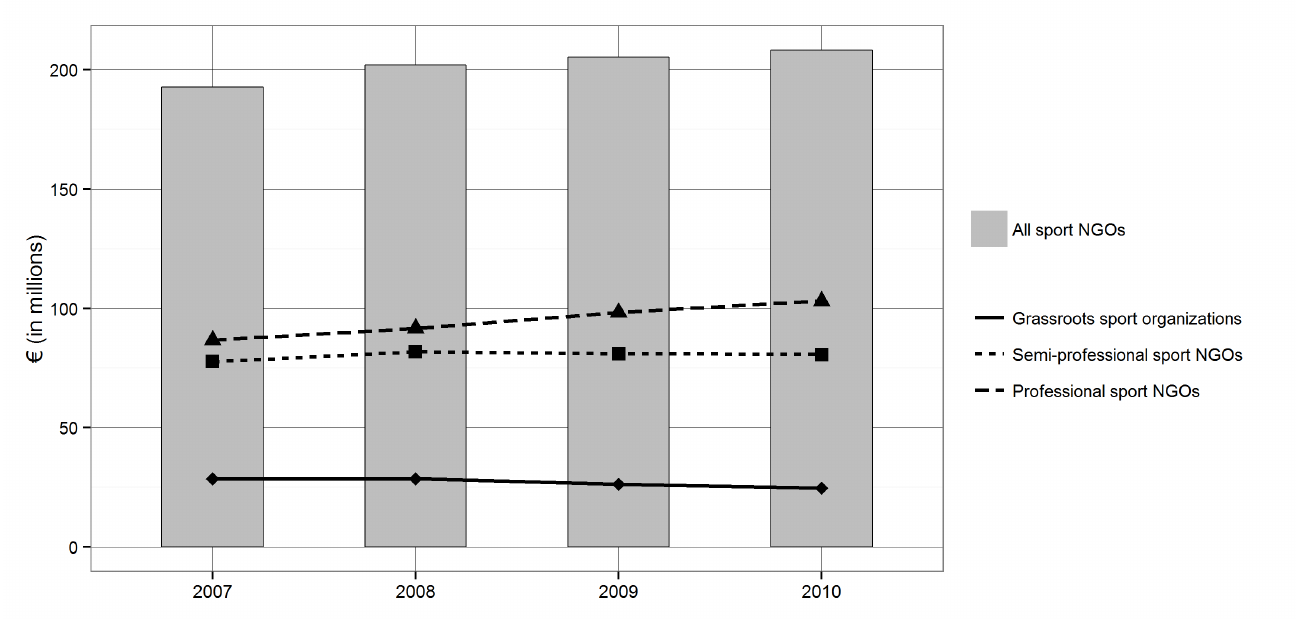
NGOs.Figure 1. Trend lines of means of total operating revenues by financial design types of sport